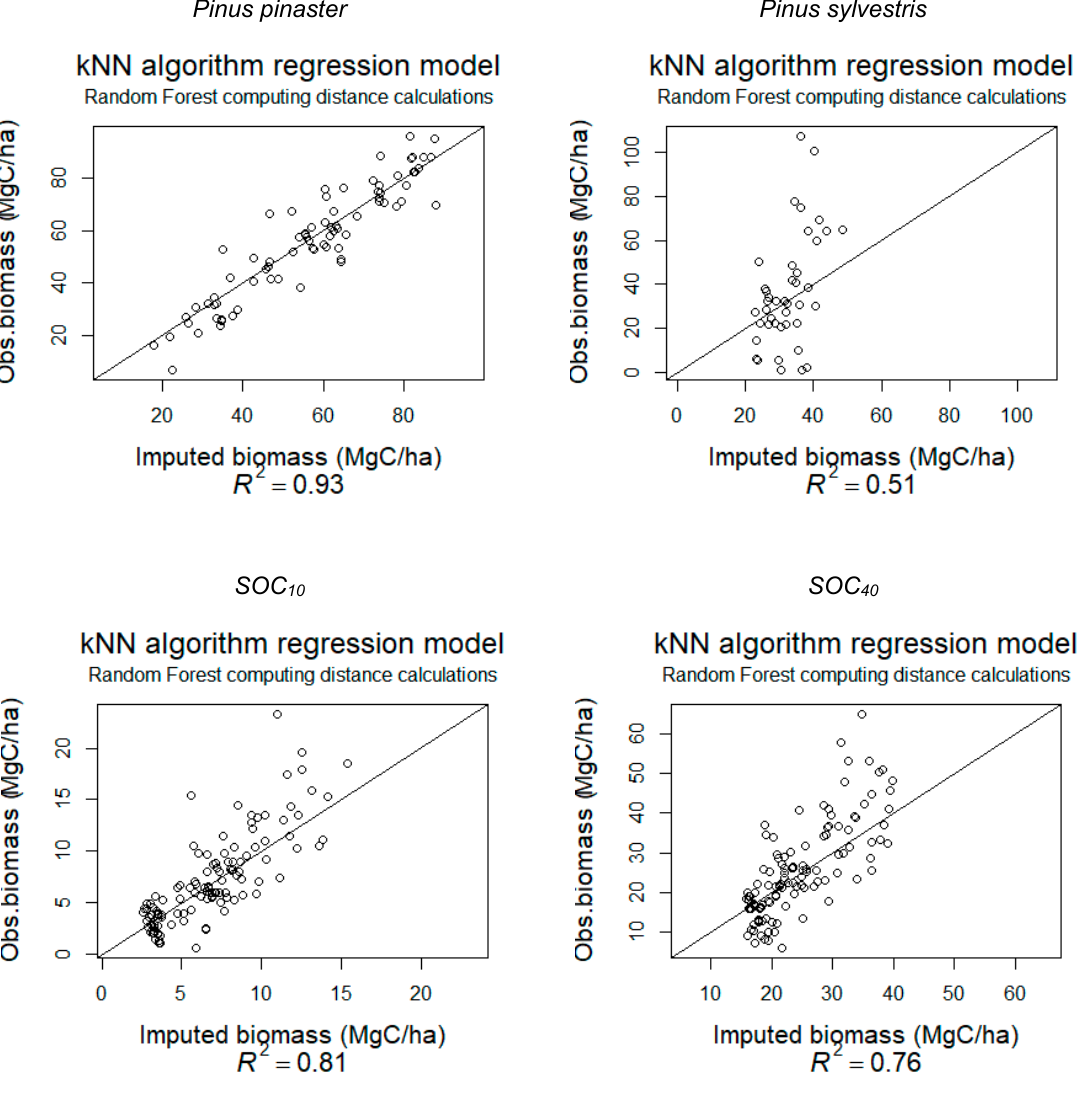
Figure 3. Bivariate relationships between the LiDAR metrics and the C stock in biomass of each pine species in the plantations at Sierra de los Filabres (Almer í a, Spain). In all figures, model results of spatialized live-biomass estimates (“modelled”) are compared to field-based measured used in existing models (“observed”). The linear 1:1 line was fitted. For these equations, the R 2 value is